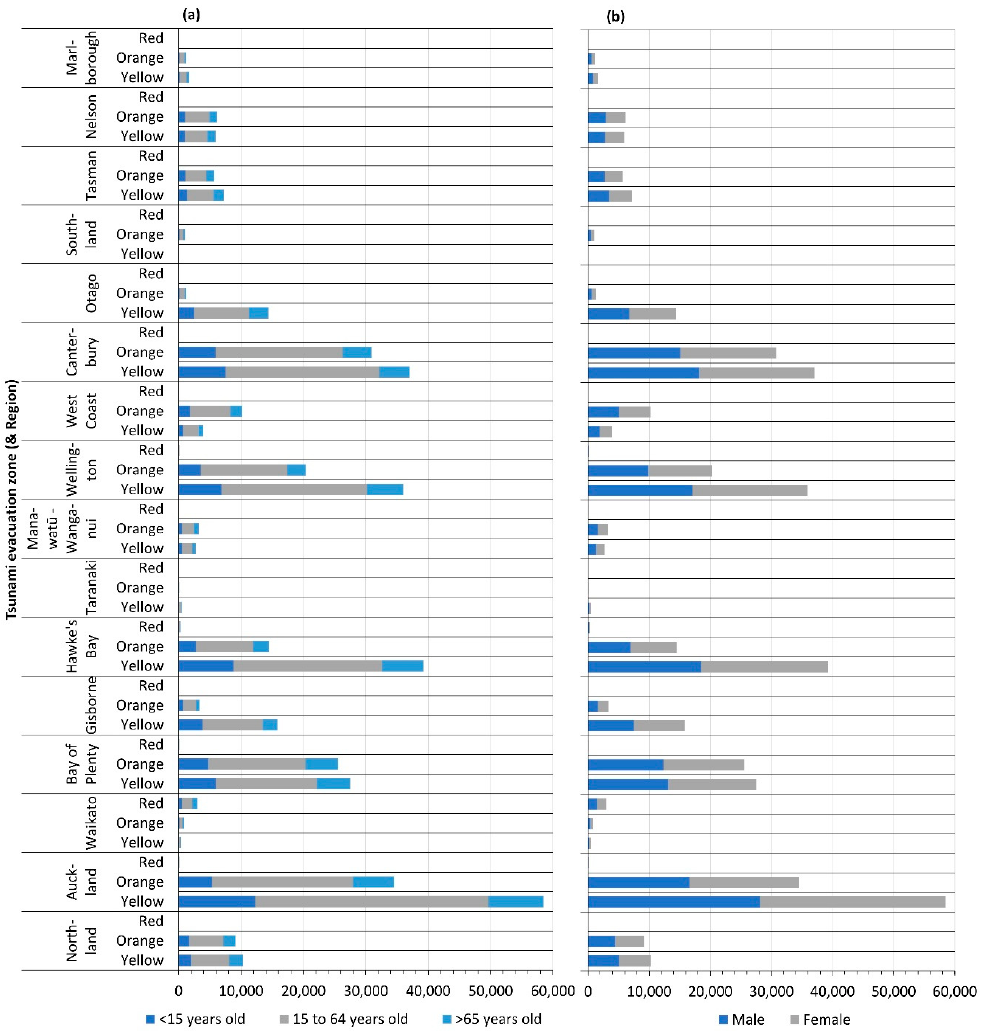
Figure 4. Regional population exposure by ( a ) age; and ( b ) gender in ‘red’, ‘orange’ and ‘yellow’ tsunami evacuation zones.